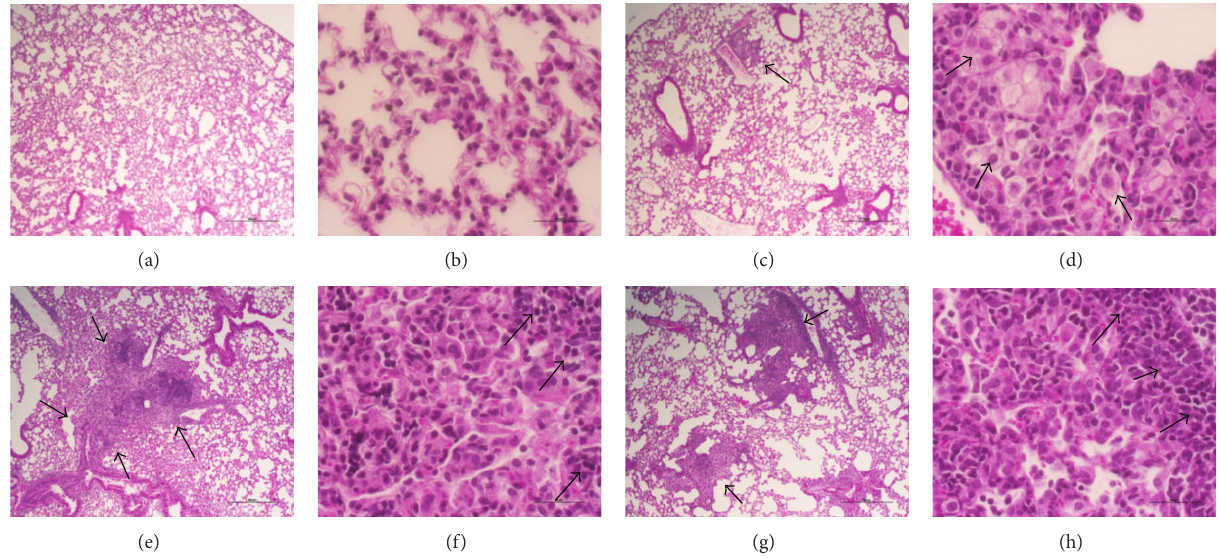
Figure 2: Histopathology of vaccinated and uninfected or Mtb-infected mice lungs. ((a)-(b)) H&E stained lung section of BCG vaccinated (for 8 weeks) and uninfected mice. ((c)-(d)) H&E stained lung section of Δ bfrB vaccinated (for 8 weeks) and uninfected mice. The arrow in (c) shows cellular aggregation. The arrows in (d) show foamy histiocytes. ((e)-(f)) H&E stained lung section of BCG vaccinated (for 8 weeks) and Mtb-infected (for 4 weeks) mice. The arrows in (e) show a multifocal, coalescent granuloma. The arrows in (f) show lymphocyte cuff at the periphery of a granuloma. ((g)-(h)) H&E stained lung section of Δ bfrB vaccinated (for 8 weeks) and Mtb-infected (for 4 weeks) mice. The arrows in (g) show multiple, smaller granulomas (compared to (e)). The arrows in (h) show lymphocyte cuff at the periphery of a granuloma. Magnification: 4x ((a), (c), (e), and (g)) or 40x ((b), (d), (f), and